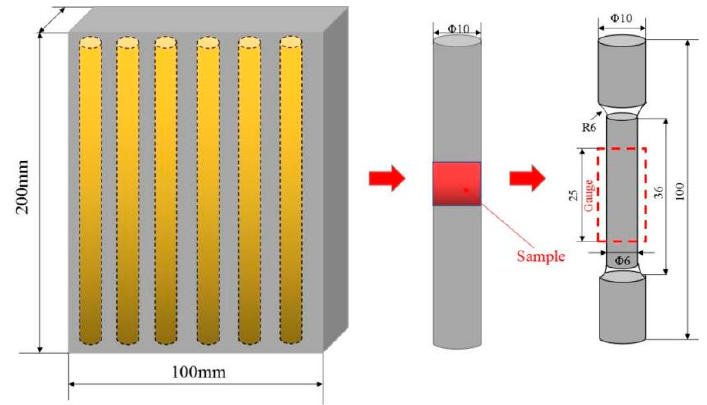
Figure 1. Schematic of the sample position for microstructural and tensile tests.